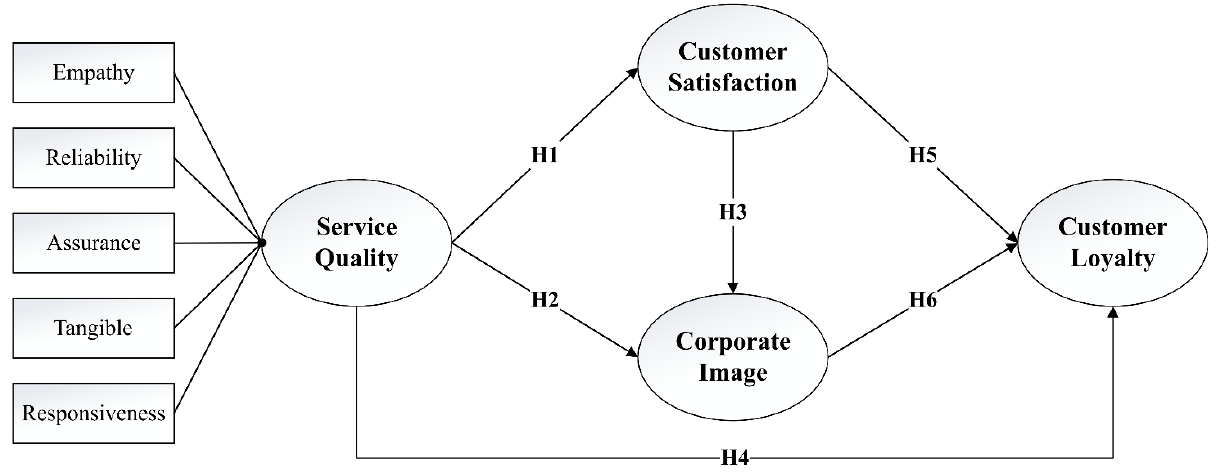
Figure 1. The research model with the proposed hypotheses.